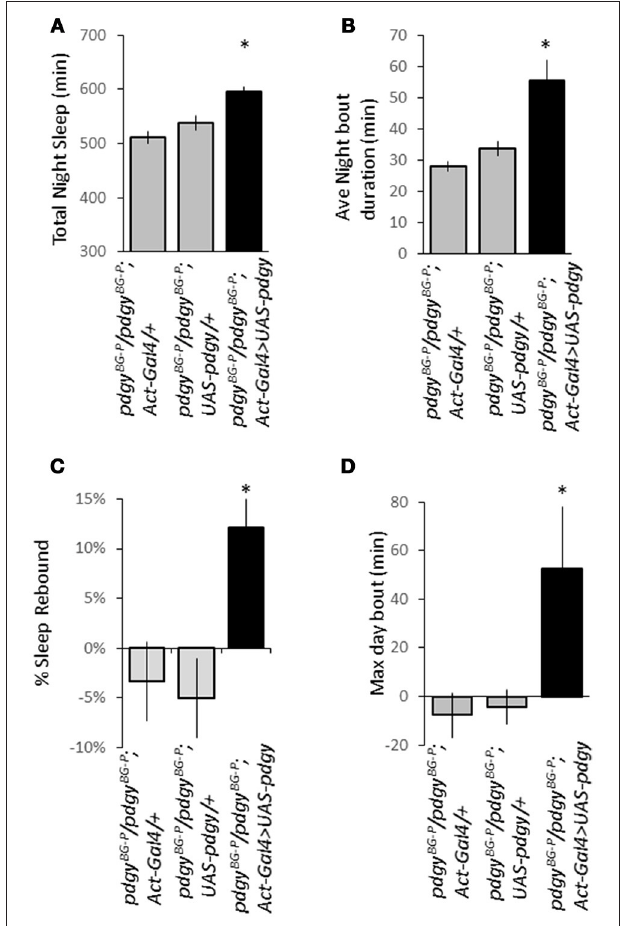
FIGURE 7 | Rescue of pdgy in the pdgy BG − P background restores sleep homeostasis, duration, and consolidation. Re-introduction of the wild-type version of pdgy (dark bars) restores the duration of night time sleep (A) and increases the average night bout duration as a measure of sleep consolidation (B) compared to the driver ( Act-GAL4/ + ) and the responder ( UAS-pdgy ) both in gray. (For both A,B , n = 63 for Act-GAL4/ + , 64 for UAS-pdgy/ + , and 61 for Act-GAL4 > UAS-pdgy). (C) Rescue also restored a significant rebound after sleep deprivation. (D) The maximum day bout is increased on the first recovery day after sleep deprivation. For (C,D) , n = 29 for Act-GAL4/ + , 26 for UAS-pdgy/ + , and 30 for Act-GAL4 > UAS-pdgy. * p <